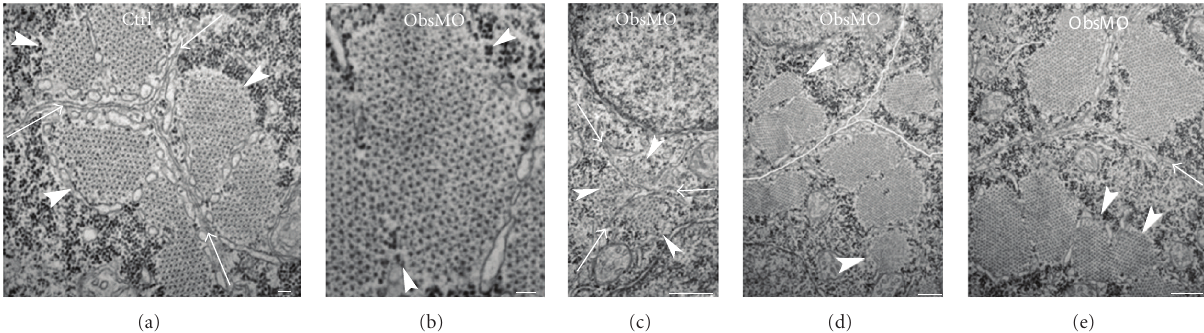
Figure 8: Obscurin depletion a ff ects membrane-myofibril interactions. Skeletal muscle from 24 hpf zebrafish embryos were evaluated by transmission electron microscopy. (a) New myofibril assembly (arrowheads) occurs along the sarcolemma (arrows), preferentially at the intersection of three myocytes. Note the well-formed sarcoplasmic reticulum that encircles the new myofibrils. (b)–(e) In obscurin A morphant embryos, the sarcoplasmic reticulum is less well developed and less closely associated with the myofibril (b). Myofibril assembly still preferentially occurs at the sarcolemmal intersections ((c): arrowheads). However, frequent “internal myofibrils” form ((d): arrowheads) and distances between superficial myofibrils and the membrane increase ((e): arrowheads). Scale bars are 100 nm (a), (b) and 500 nm (c),